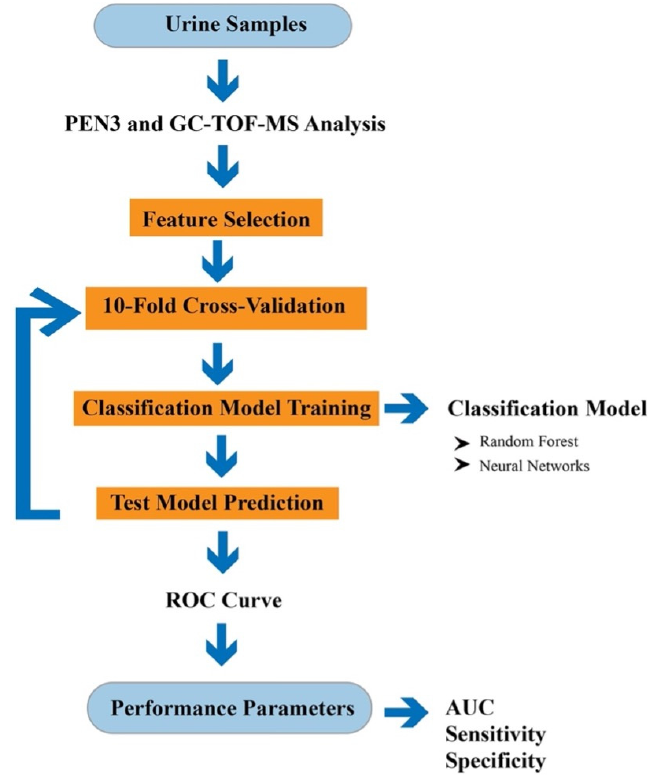
Figure 1. Flowchart of the data analysis used in this study.